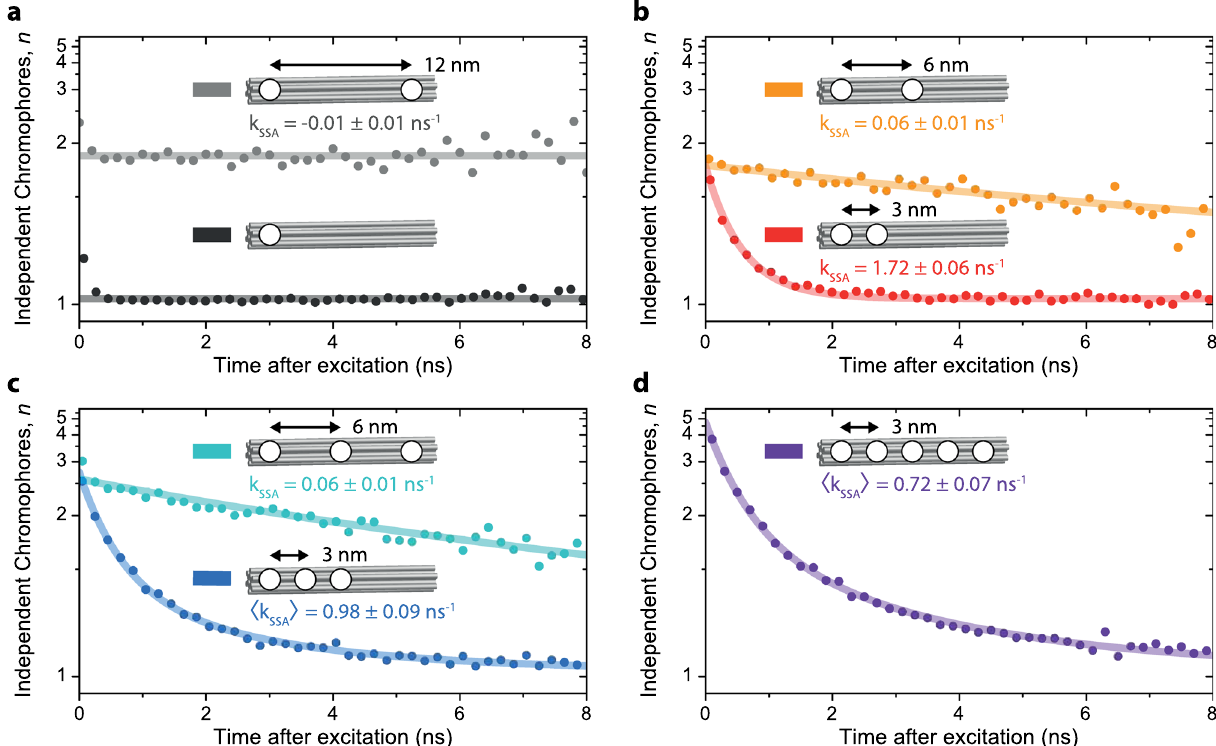
Fig. 3 Exciton annihilation in multiple well-de fi ned mcNPs. Evolution of the number of independently emitting chromophores, n , as a function of the time after excitation for seven different structures. The structures have different numbers of dyes attached with different spacings between them. The y -axes are reciprocal for better comparison between the graphs. a One dye (dark grey) and two dyes separated by 12nm (light grey). b Two dyes separated by 3 nm (red) and 6 nm (orange). The curves superimposed are described by a monoexponential model of exciton annihilation (Eq. (2)). c Three dyes separated by 6 nm (cyan) and 3nm (blue). The cyan curve is described by Eq. (2), but the blue points follow a biexponential decay with an average rate k SSA (Eq. (3)). d Five dyes separated by 3 nm. The curve is described by the biexponential decay of Eq. (3). Between 54 and 98 single mcNPs were measured individually, and the photon statistics of each measurement accumulated to obtain each curve. All measurements were performed under oxygen removal and with a reducing and oxidizing system (ROXS) present to ensure photostabilization 30 . Each particle was measured for only 5s so that photobleaching and spectral shifts were